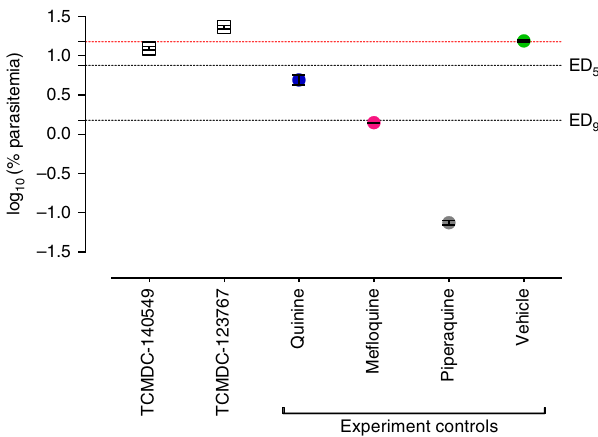
Figure 7 | Effect of two TCAMS hits in the P. berghei in vivo mouse model. Each experiment included a control group treated with vehicle (green circle) used as a reference to calculate the percentage of inhibition of parasitaemia in peripheral blood (dotted red line). The response of standard antimalarials in the same assay is also presented (blue, magenta and grey circles). Represented data are the mean ± s.e.m. log 10 [% asexual blood stages at day 4] of two mice per point.